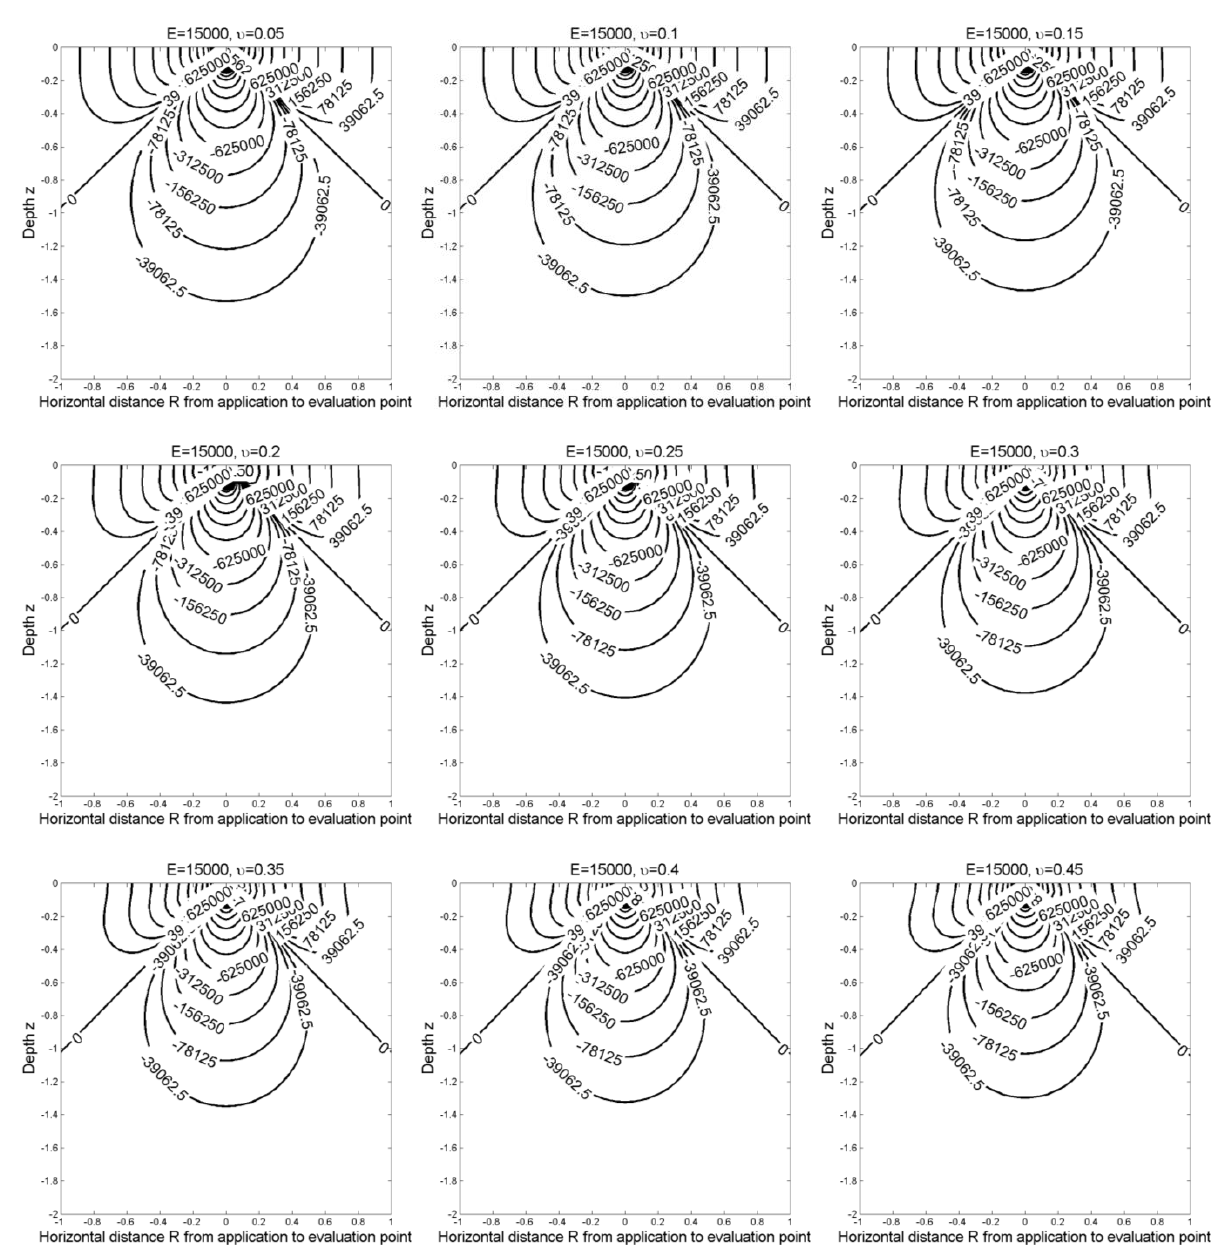
Figure 7: Parametric analysis on υ for the vertical stress contours (all distances in mm) (from